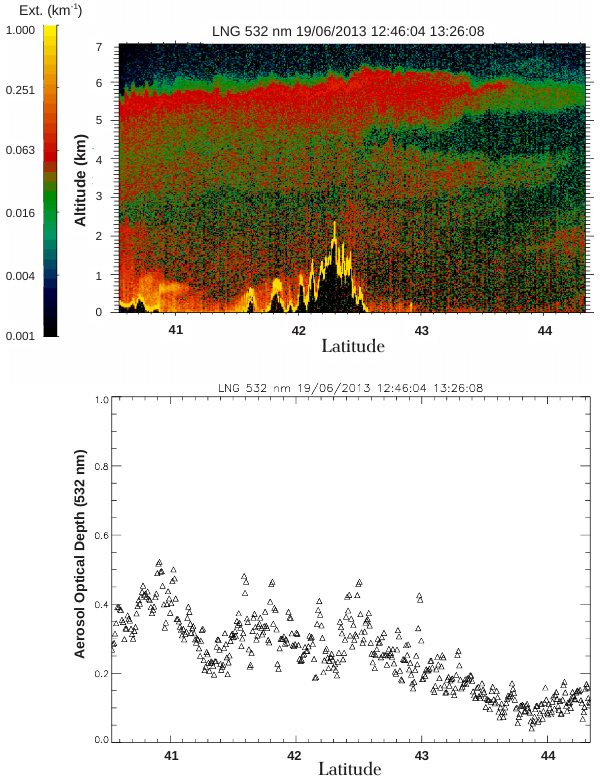
Figure 24. Observations of aerosol extinction coefficient (top, in km − 1 at 532nm) and aerosol optical depth (bottom) obtained from the lidar LNG system onboard the F-20 aircraft during 19 June that corresponds to the flight (12:46 to 13:26) from Cagliari to the Gulf of